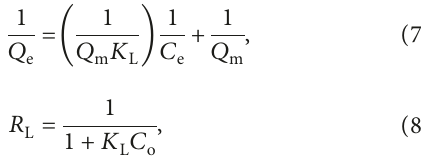
Table 2: Kinetic parameters of the CR adsorption models over MnFe